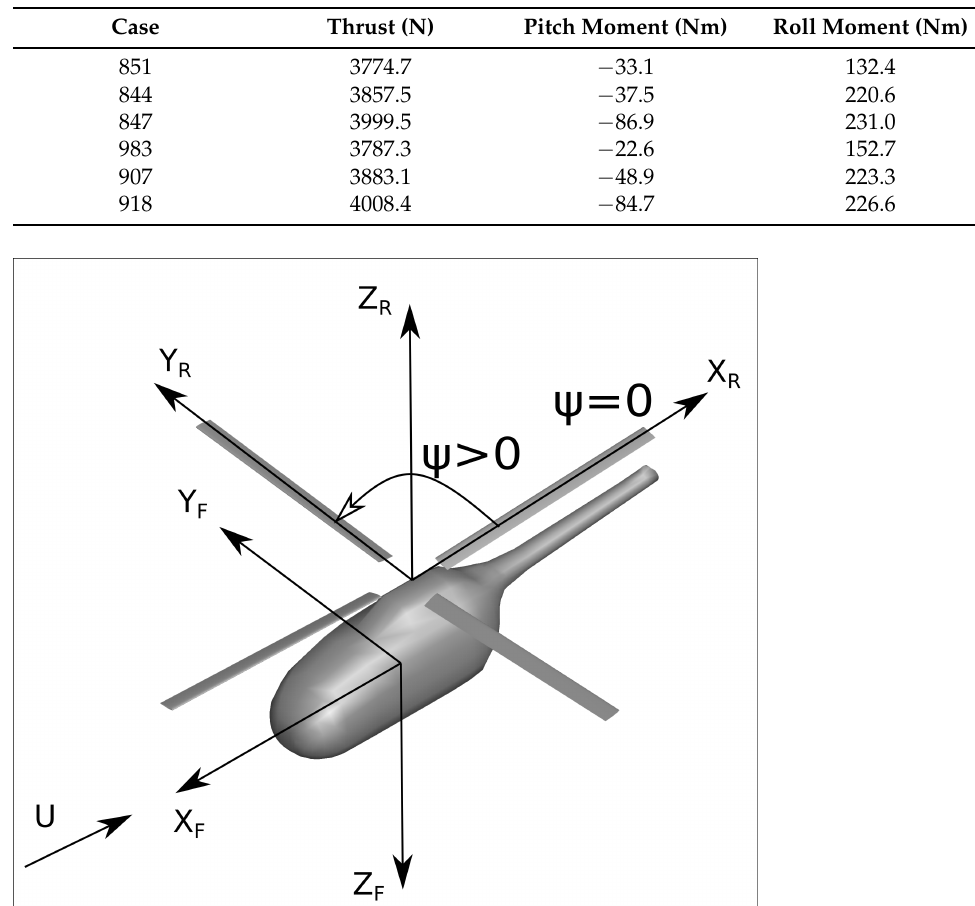
Figure A2. BO105 Fuselage (F) and Rotor disk (R) coordinate